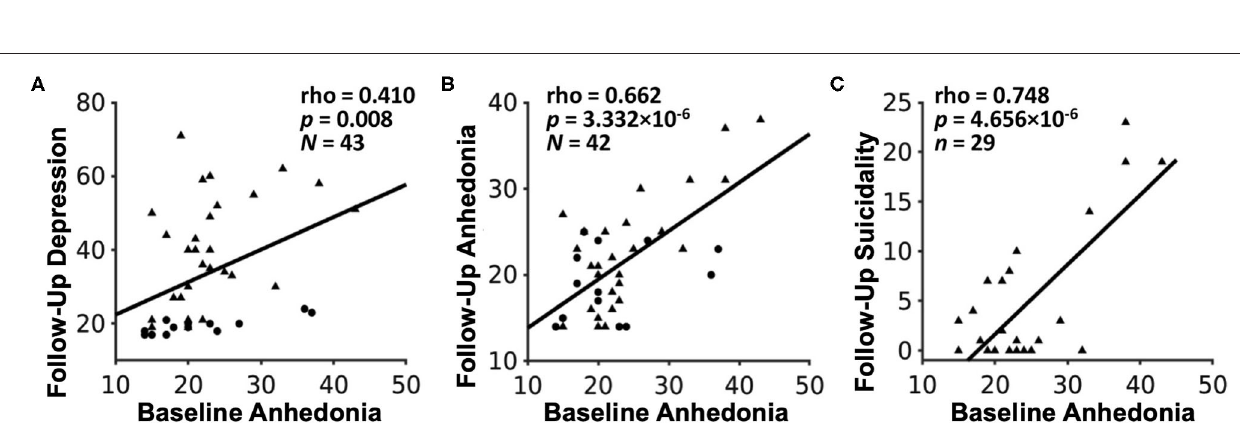
FIGURE 2 | Associations between anhedonia severity and (A) overall depression severity (CDRS-R minus the anhedonia question), (B) suicidality (Beck Scale for Suicidal Ideation), and (C) episode duration (months) in a sample of 90 depressed adolescents. Scatterplots superimposed with Spearman correlation lines of best fit. Adapted from (54).